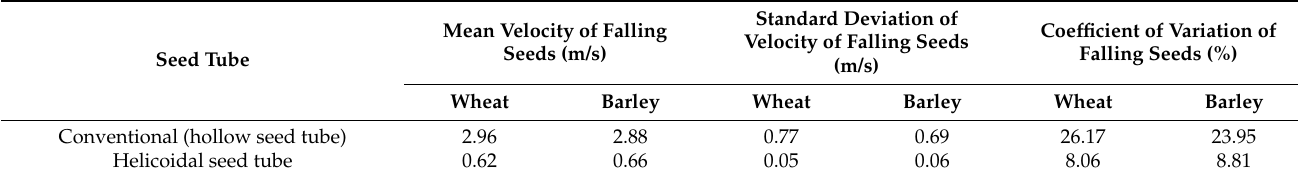
Table 8. The effect of seed tubes on the velocity of falling